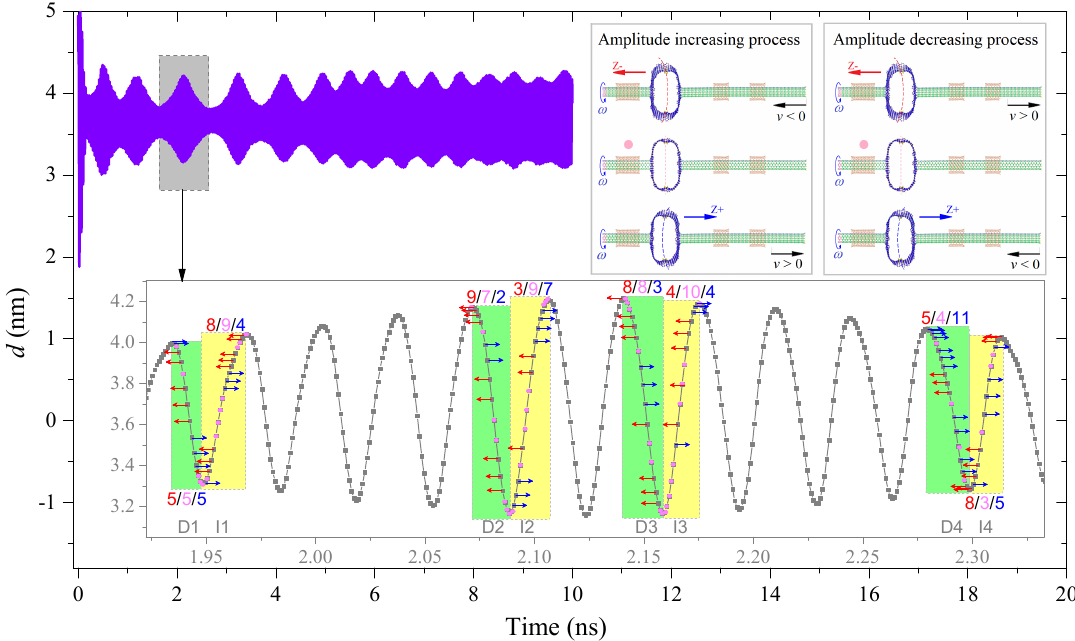
Figure 8. “Beat” phenomenon in the d curves of the Z2H2 system with ω = 70 GHz at 8 K.